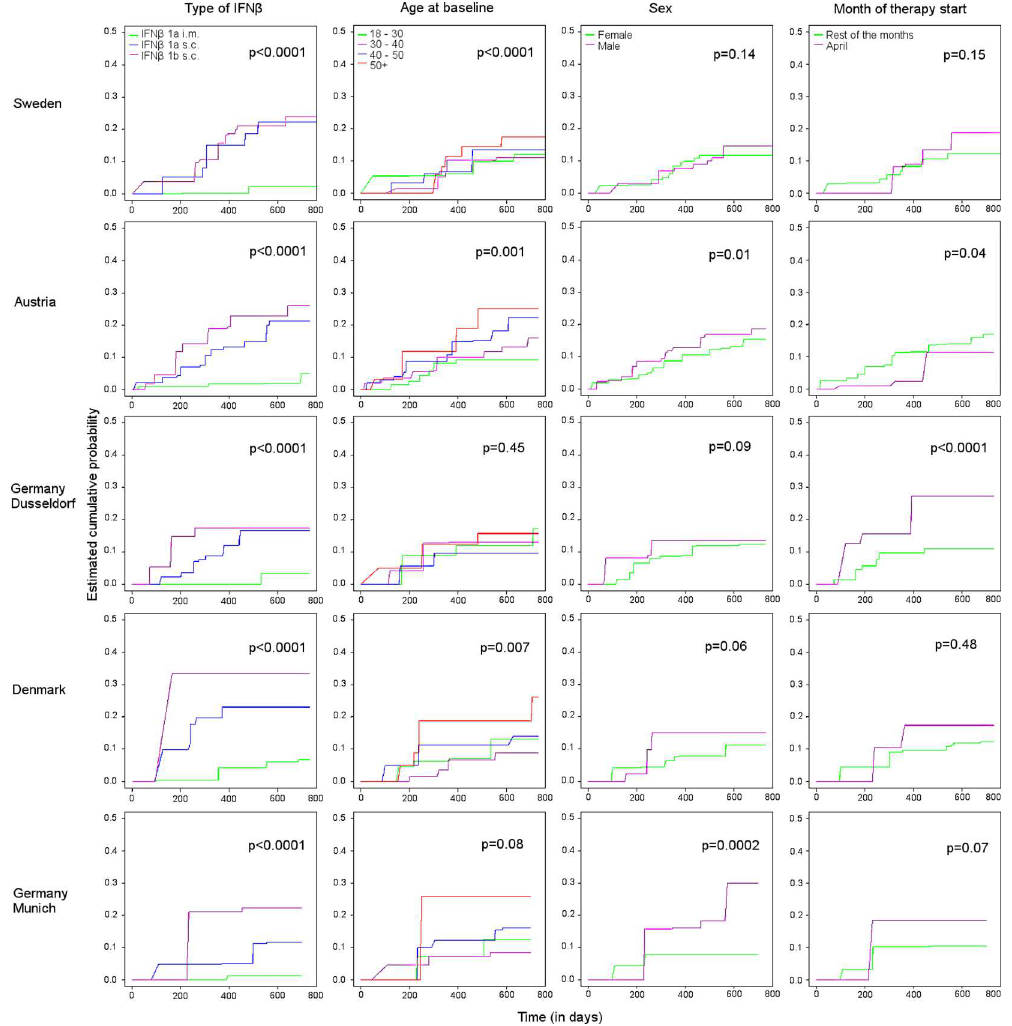
Fig 2. Cumulative probability of developing anti-IFN β ADA. Estimated cumulative probabilityof developing anti-IFN β ADA by cohort and by categorical variableswith p-values for rank-basedtests adaptedfor interval